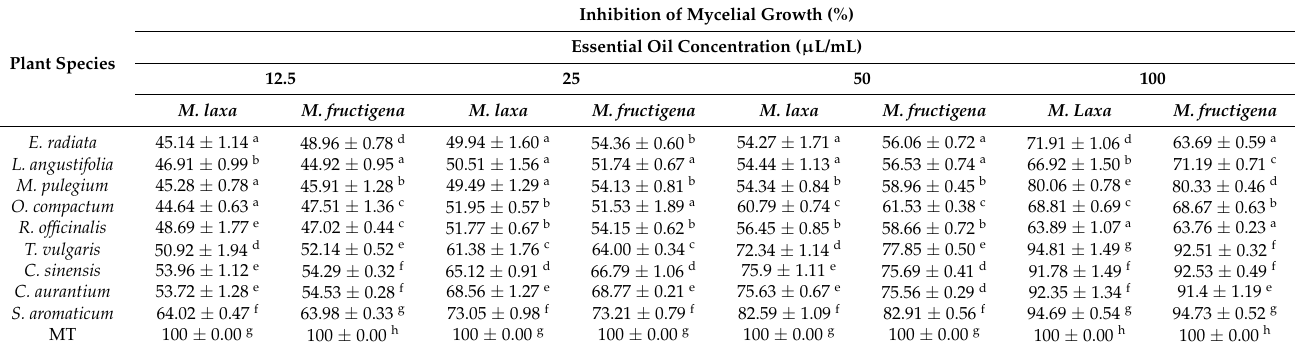
Table 1. In vitro effect of various essential oil concentrations on mycelial growth of Monilinia laxa and Monilinia fructigena incubated at 25 ◦ C for 7